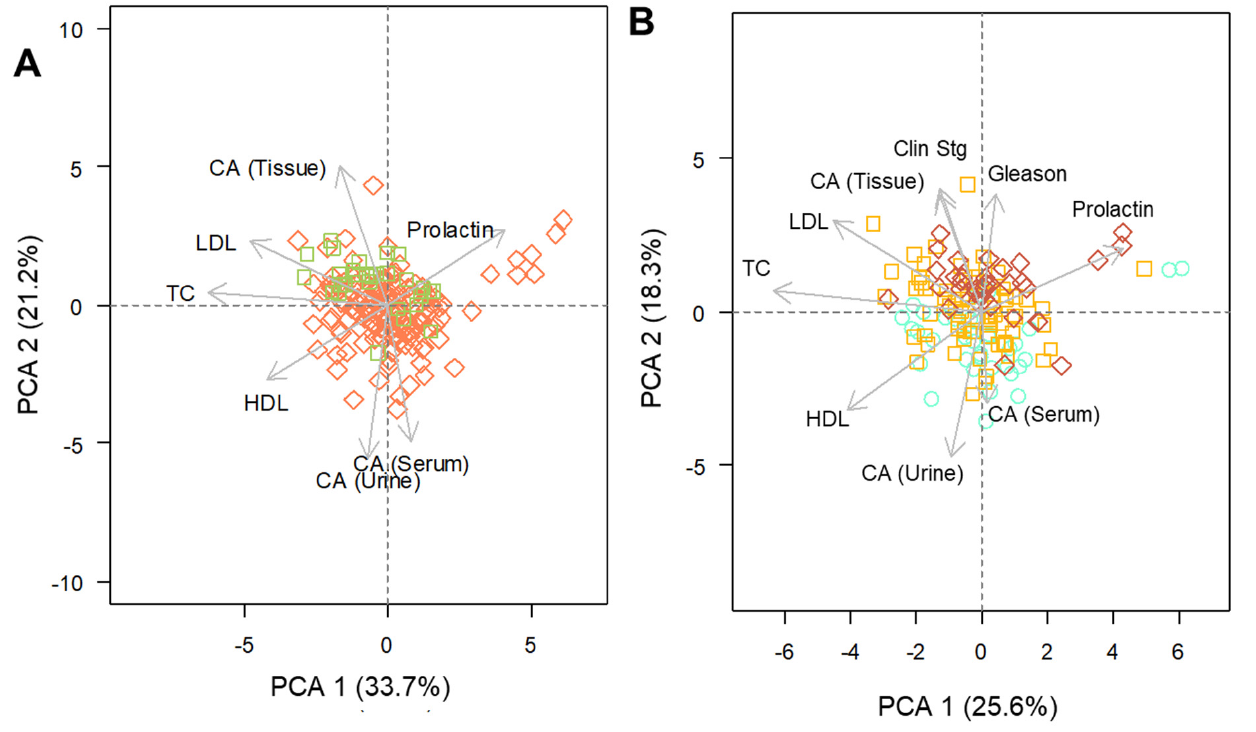
Figure 4. PCA correlation biplot of data comprising the evaluated parameters for ( A ) both groups and ( B ) within positive class. In ( A ): green squares = control cases and red diamonds = positive cases; In ( B ): green circles = GS < 7, yellow squares = GS equal to 7 and red diamonds = GS > 7. CA = citric acid, LDL = low density lipoprotein, TC = total cholesterol, HDL = high density lipoprotein and Clin Stg = cancer clinical staging.